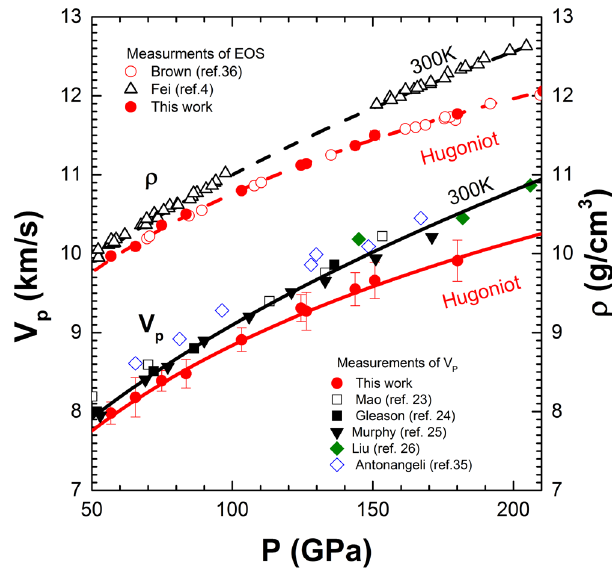
Fig. 2 The density and compressional wave velocity ( V P ) of Fe as a function of pressure along the Hugoniot and 300-K isotherms. The Hugoniot densities of Fe 36 are compared with new Hugoniot data of this study and static data at 300 K 4 , along with the fi tted results represented by the dashed lines. The red solid circles represent the measured V P under shock compression (this work), compared with the static V P data 23 – 26,35 . The black and red curves represent the calculated V P as a function of